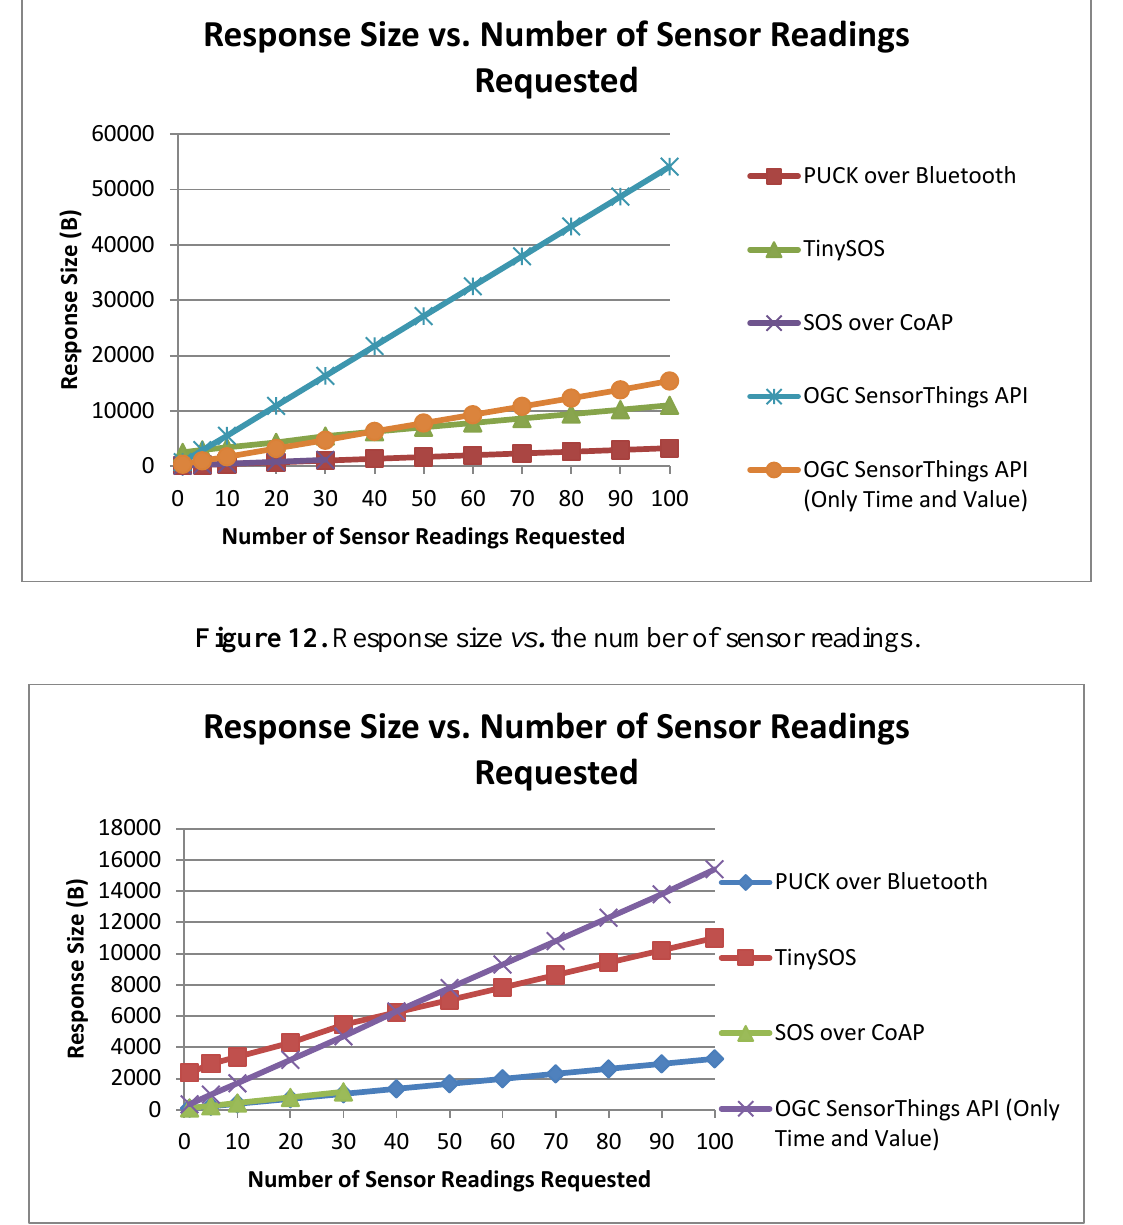
Figure 13. Response size vs. the number of sensor readings (removed the OGC SensorThings